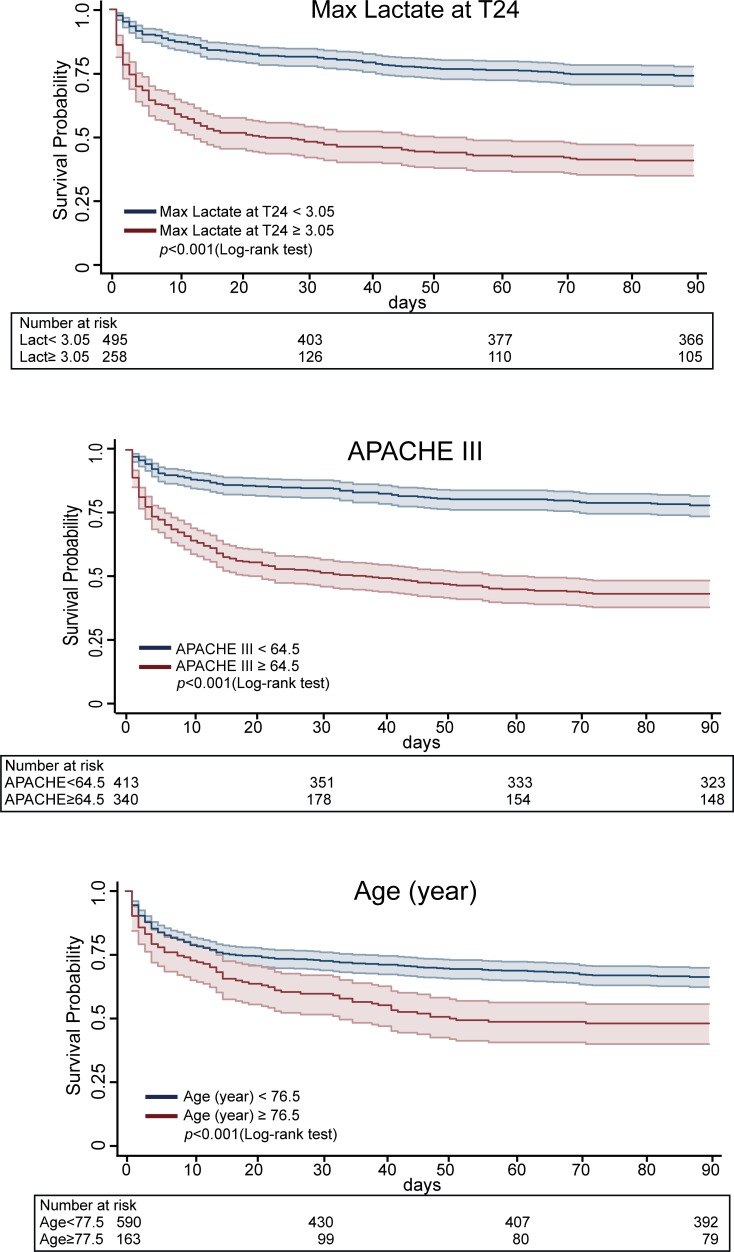
Kaplan-Meier survival curve with risk tables and 95% confidence intervals of Max lactate at T24, APCHE III score, and age for 90-day survival after ICU admission.